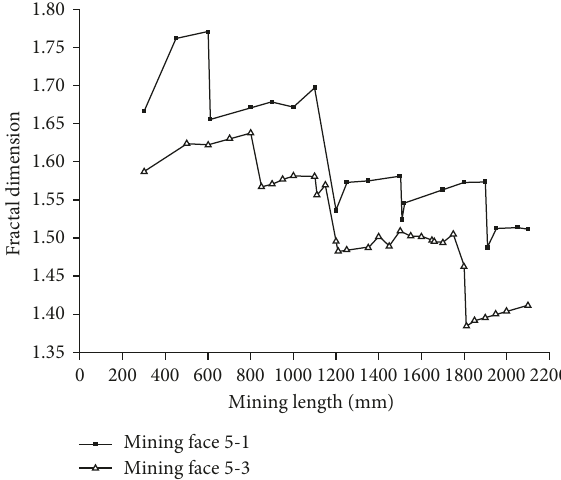
Figure 7: Relationship between the fractal dimension and mining length with different mining